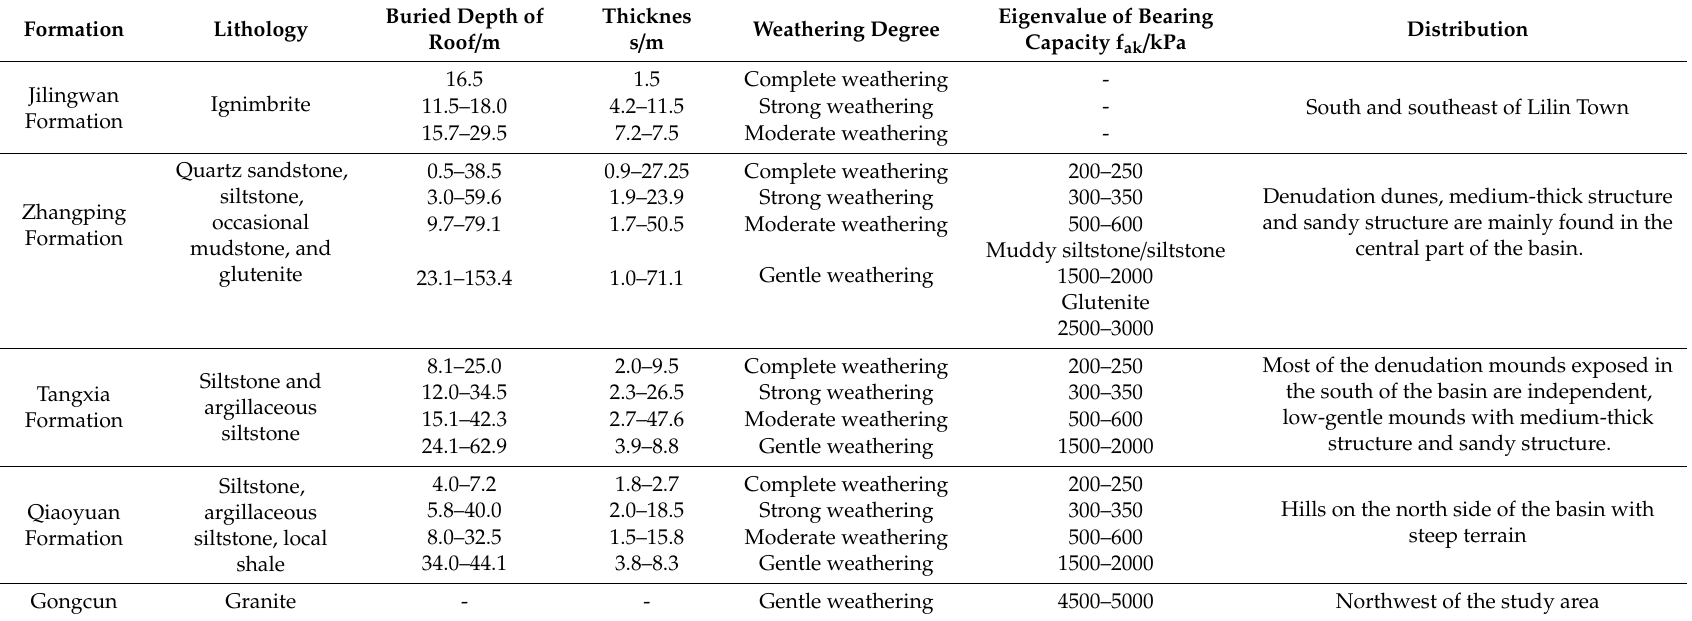
Table 1. Characteristics of the bedrock in the study